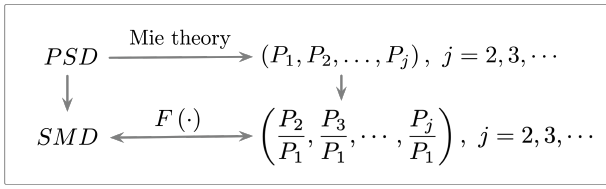
Figure 2. The derivation scheme of T SMD .